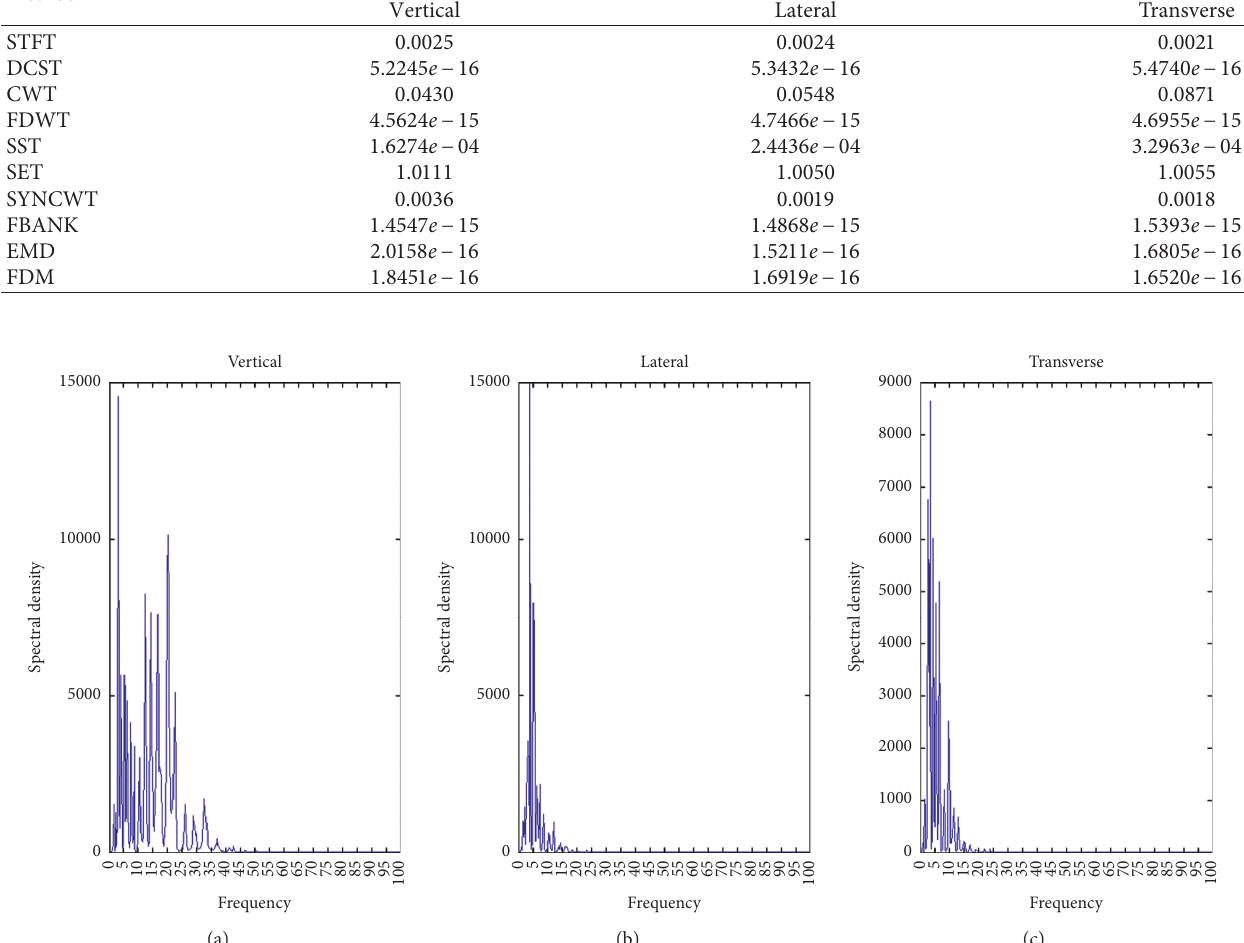
Figure 12: Marginal Spectrum computed by FDM for Mosha3 three component